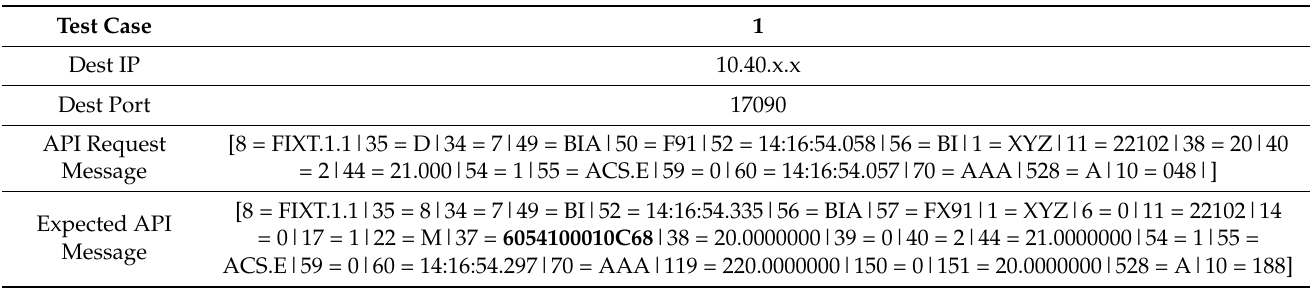
Table 2. An example of a test case for FIX API protocol extracted from the pcap file—new operation.